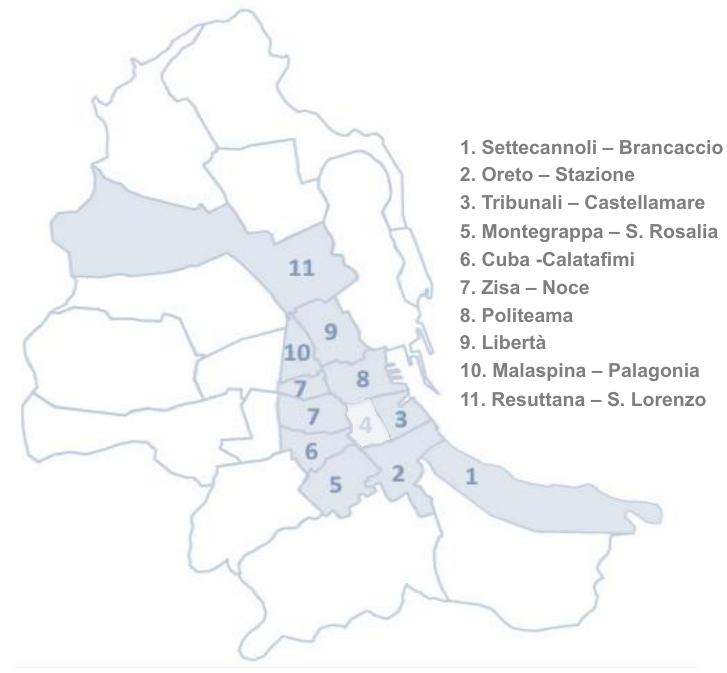
Figure 2. The 10 neighbourhoods in the case study.